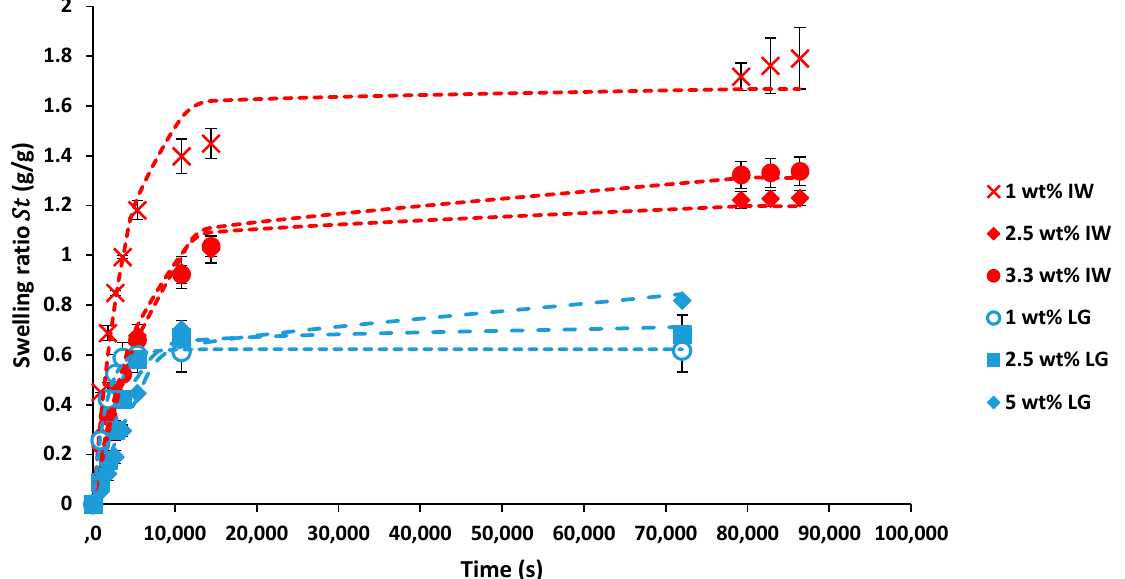
Figure 1. Water retention test results of hydrogels produced using different concentrations (1, 2.5 and 3.3 wt%) of laboratory-grade (LG) alginate solutions and hydrogels produced using industrial kelp solid waste extracted alginate slurries (IW) with different solid contents (1, 2.5 and 5 wt%). The swelling ratio is a fractional indication of the mass of liquid absorbed per mass of dried hydrogel. Error bars show standard deviation from triplicate experimental runs. The dotted lines indicate results achieved through fitting the Voigt model.